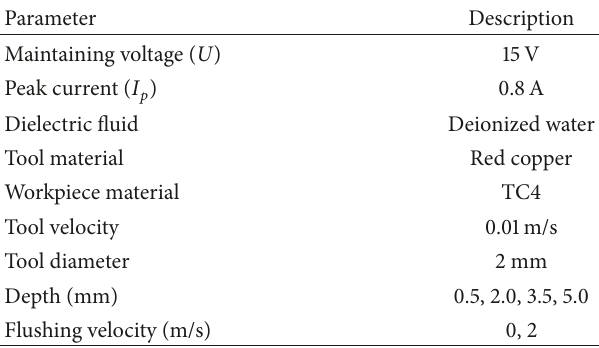
Table 2: Continuous discharge simulating